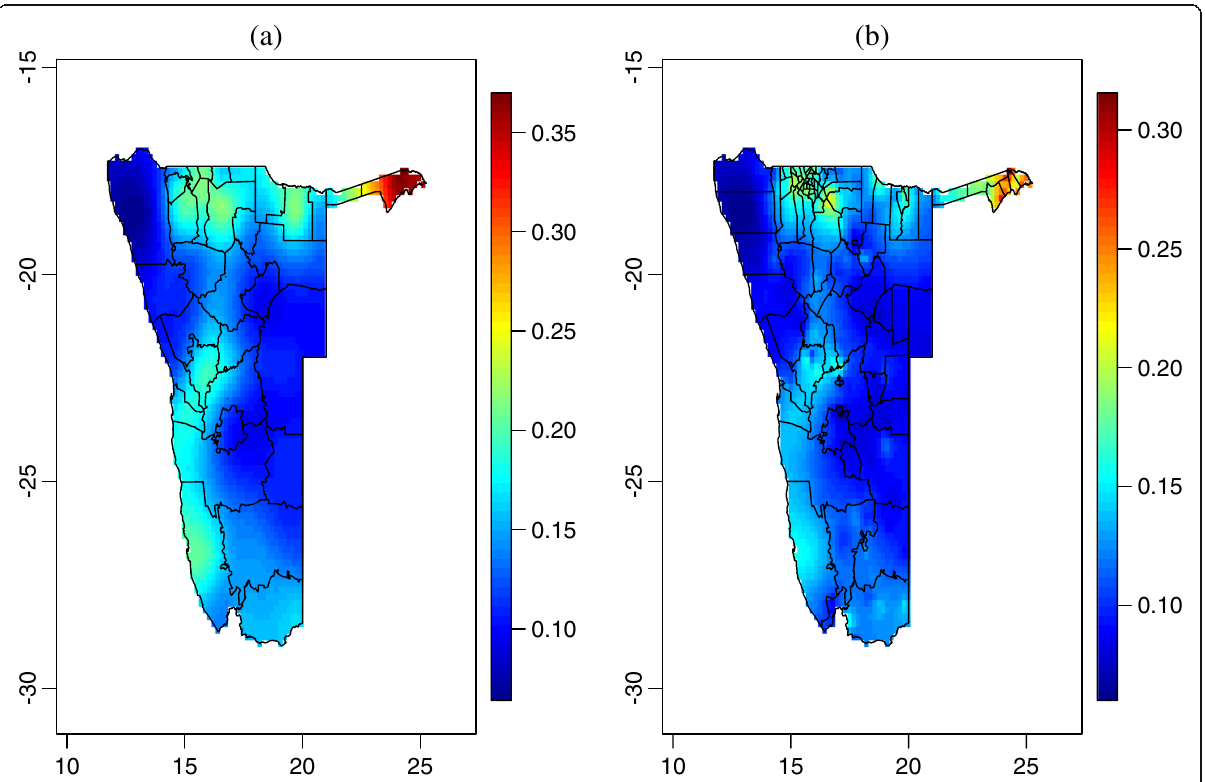
Fig. 4 Estimated HIV prevalence using bivariate model: ( a ) HIV prevalence estimates from 2014 NHSS data; ( b ) HIV prevalence estimates from 2013 NDHS data